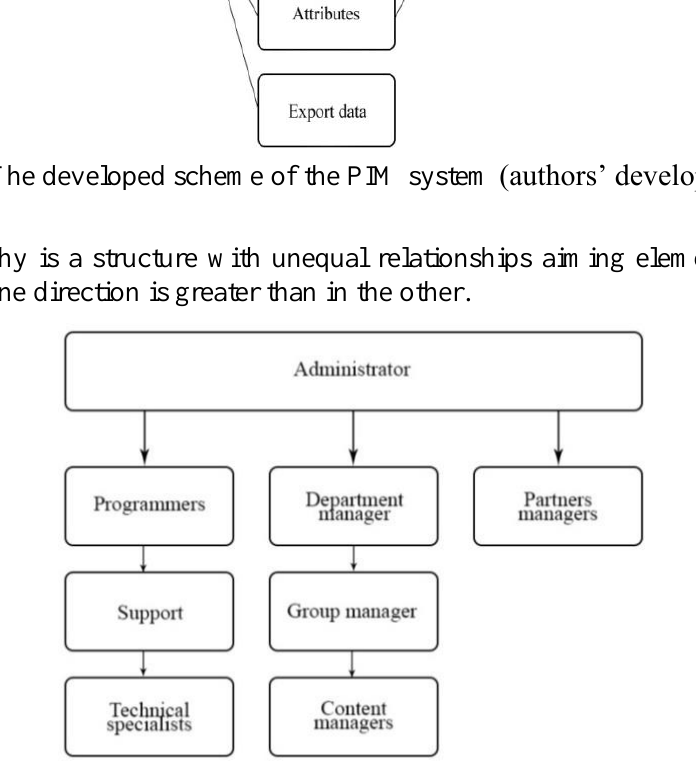
Fig. 3. Hierarchical structure (interoperability) of the PIM system (authors’